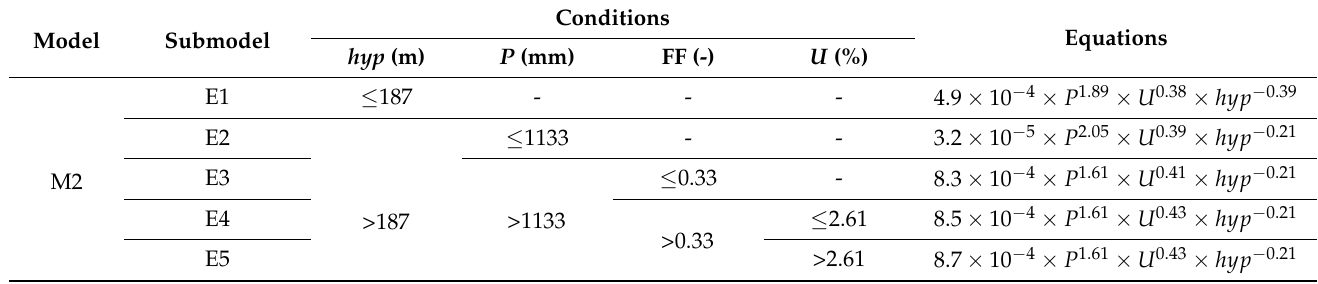
Table 2. Application conditions and determination coefficients of model 2 (M2, SD values based on